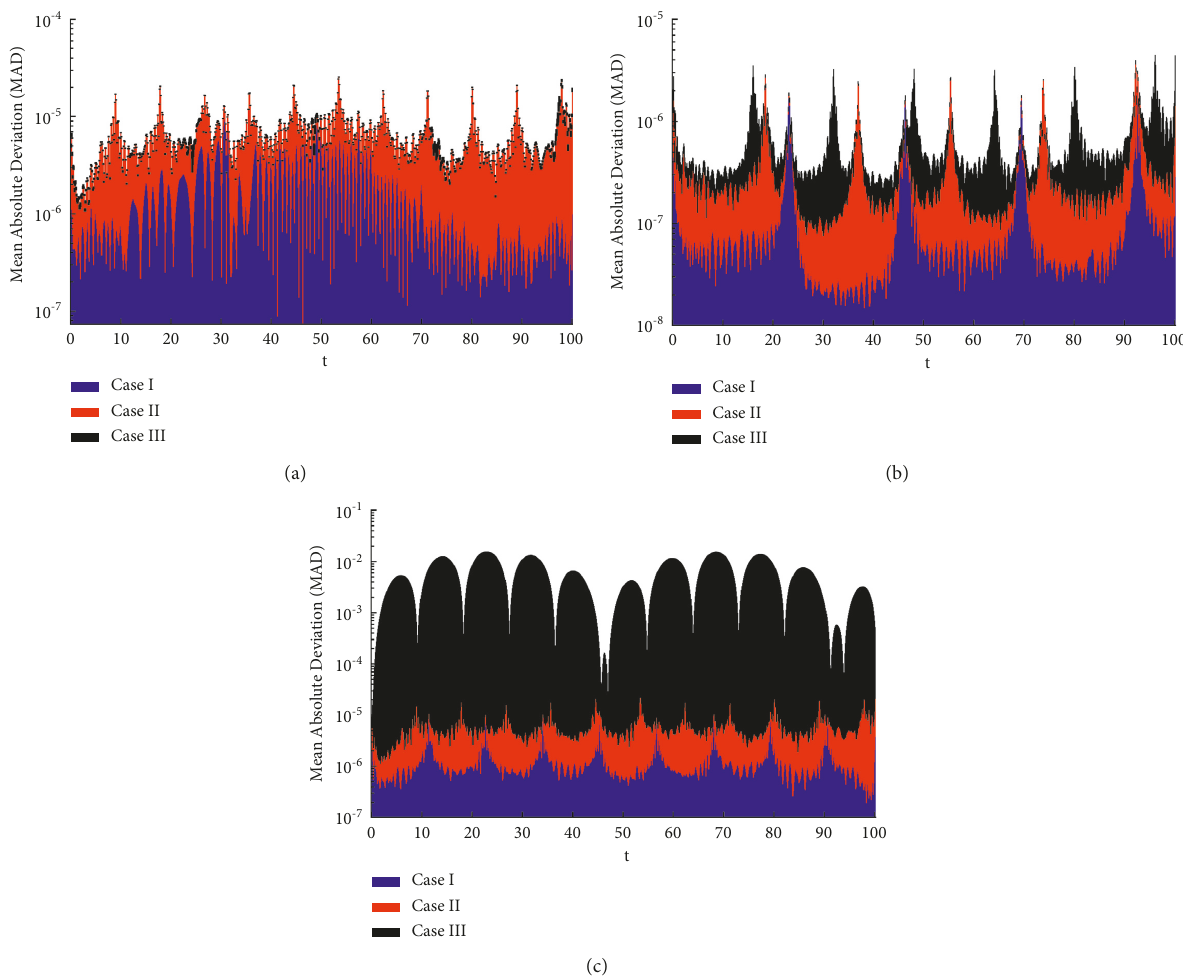
Figure 8: Behavior of values of mean absolute deviations for different scenarios and cases of equation (3).